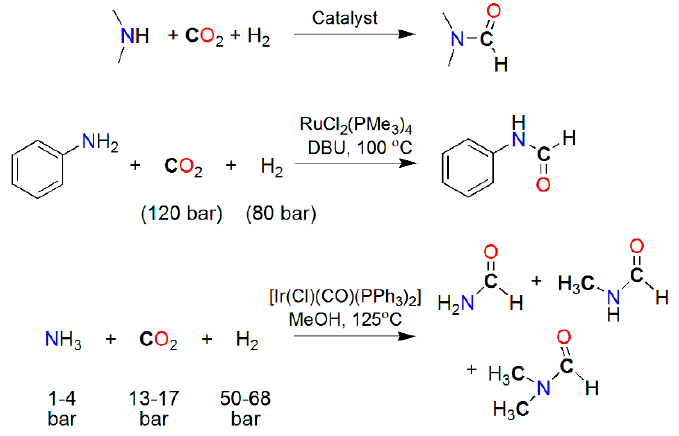
Table 3. A comparison of metal-catalyzed N–H formylation of selected primary and secondary amines with CO 2 . dppm—bis(diphenylphosphino)methane; dppe—bis(diphenylphosphino)ethane; PNP— N , N -bis(2-(diphenylphosphinoethyl)methylamine; dmpe—bis(dimethylphosphino)ethane; PP 3 —tris[2-(diphenylphosphino)ethyl]phosphine; (diphenylphosphino)phenyl)phosphine;